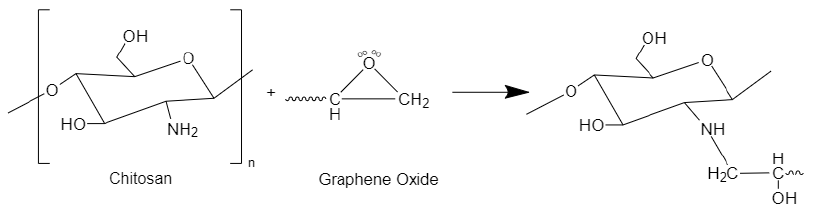
Figure 1. Cross-linking mechanism between chitosan and an epoxy group present on a graphene oxide surface.